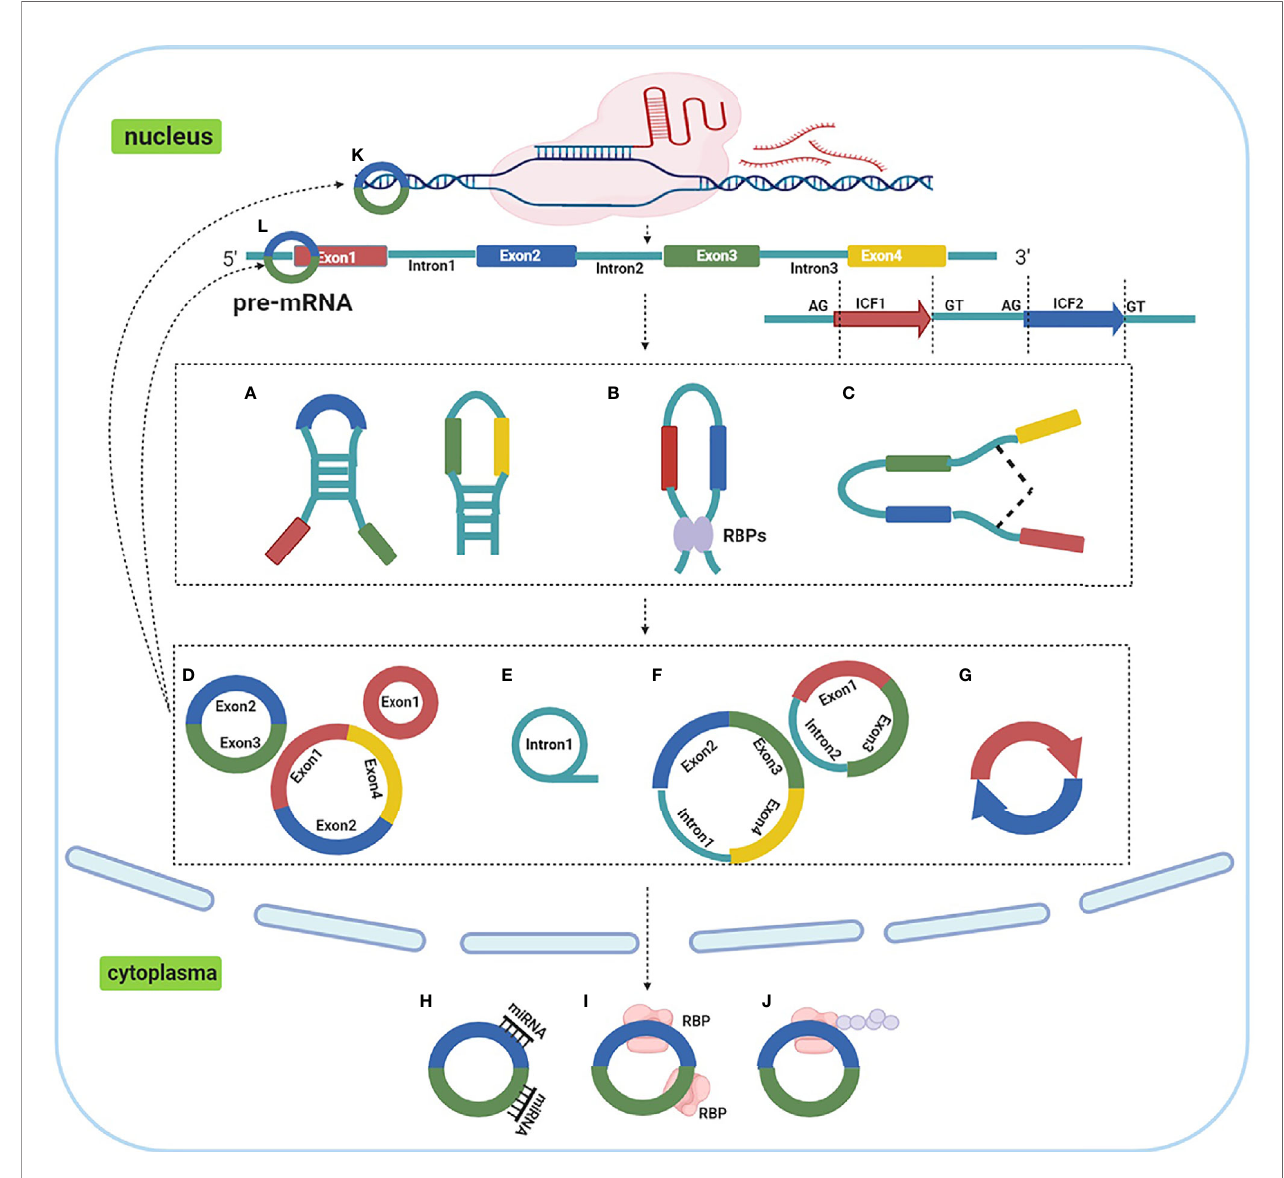
FIGURE 1 | Biogenesis, categories and functions of circRNAs. (A) . reverse complementary intronic sequence paring; (B) RNA binding protein regulation; (C) alternative splicing; (D) . ecircRNAs; (E) ciRNAs; (F) ElciRNAs; (G) intergenic circRNAs; (H) . act as ceRNA or miRNA molecular sponges; (I) interacting with RNA binding proteins; (J) peptide translation; (K) transcriptional regulation; (L) modulating miRNA